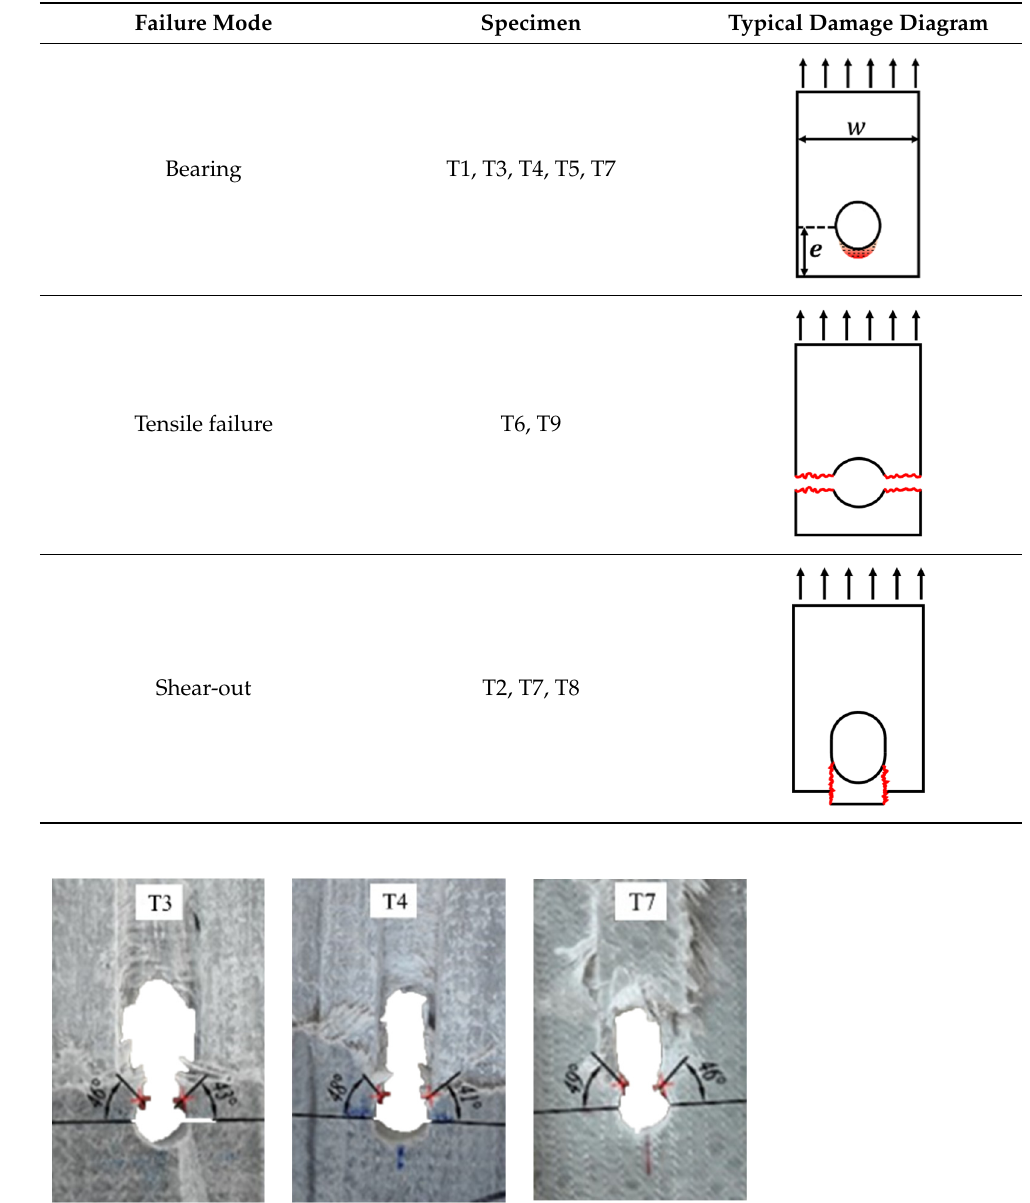
Table 2. Classification of failure modes of GFRP bolted joints.